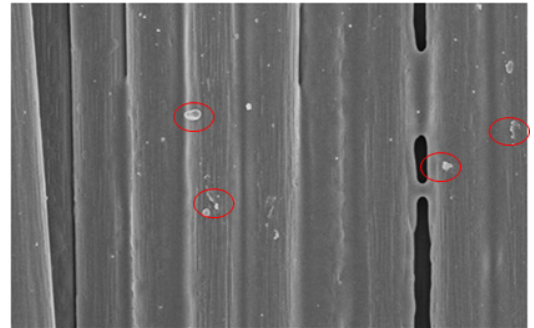
Figure 2. Sizing state of carbon fibers.